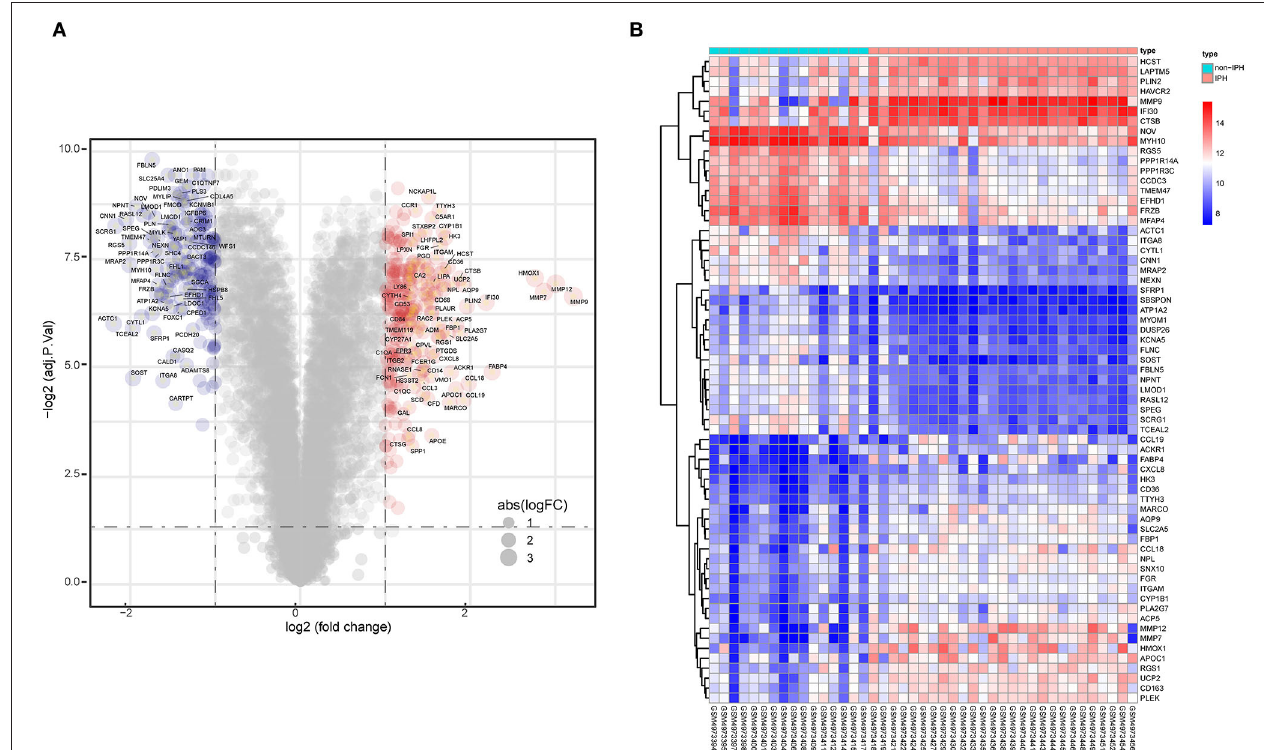
FIGURE 3 | Identification of DEGs between non-IPH samples and IPH samples. (A) Volcano plot showing the DEGs between non-IPH and IPH groups after analysis of the GSE163154 dataset with R software. The x-axis represents the fold-change (log-scaled) and the y-axis represents the p -value (log-scaled). Red symbols represent upregulated genes, blue symbols represent downregulated genes, and gene name symbols represent the DEGs with the greatest magnitude of fold-change. (B) A heatmap showing the DEGs between the two groups. Upregulated genes are labeled in red and downregulated genes are shown in blue.